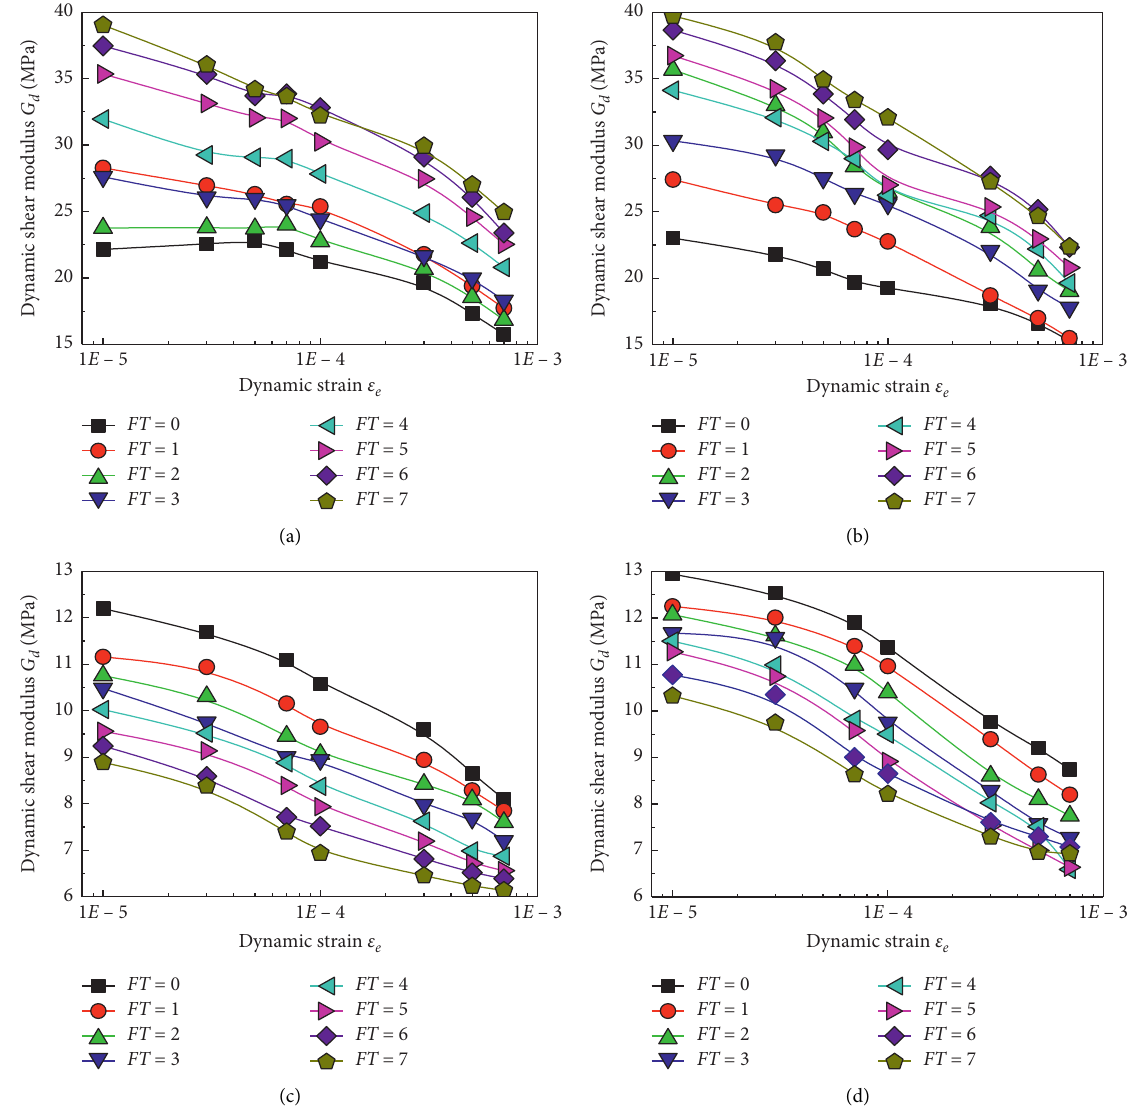
Figure 8: The relationship between dynamic shear modulus G d and dynamic strain ε e of the unreinforced and reinforced expansive soil under the conditions of the freeze-thaw cycle. (a) σ 3 � 50kPa, unreinforced samples. (b) σ 3 � 50kPa, reinforced samples. (c) σ 3 � 10kPa, unreinforced samples. (d) σ 3 � 10kPa, reinforced